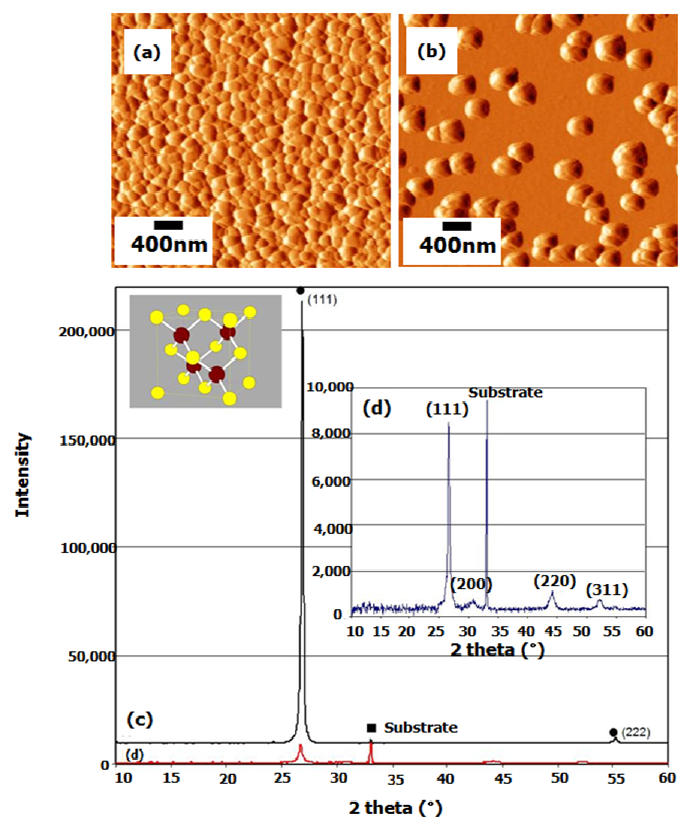
Figure 6. Comparison study of CdS film grown by the MASD with CBD: AFM image of the film by ( a ) the MASD and ( b ) the CBD, respectively; the XRD spectrum of the film by ( c ) the MASD and ( d ) the CBD, respectively. Reproduced from [29].